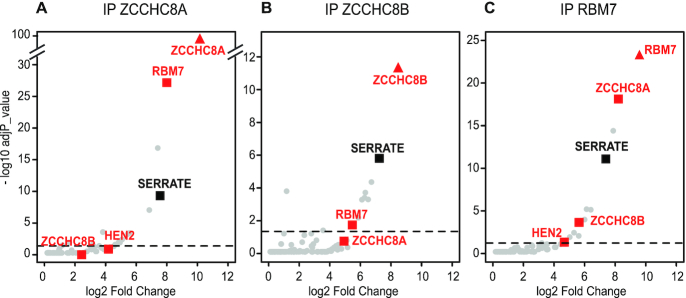
The interaction of SE with the NEXT complex is confirmed by reciprocal IPs. Volcano plots showing the proteins co-purified using GFP-tagged versions of (A) ZCCHC8A, (B) ZCCHC8B and (C) RBM7 as baits as compared to control IPs performed in Col-0. The bait proteins are indicated by triangles. The proteins above the threshold (adjp < 0.05, dashed line) are significantly enriched.